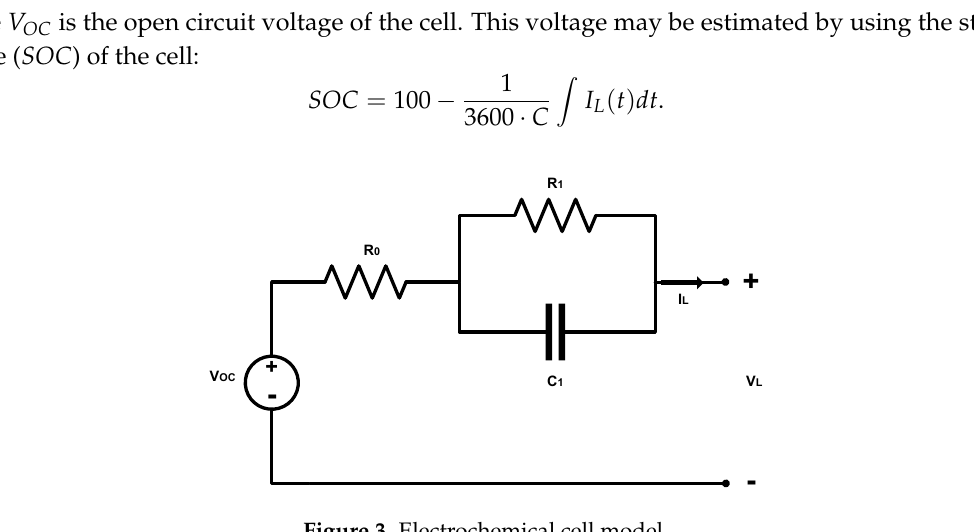
Figure 3. Electrochemical cell model.